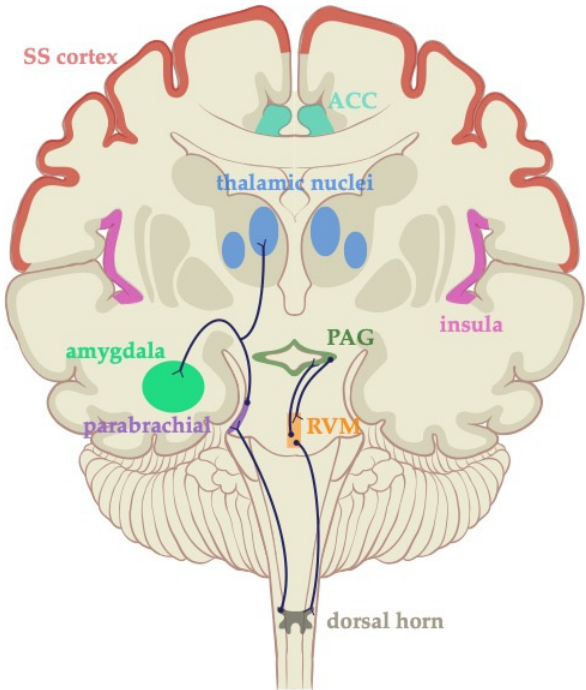
Figure 2. Descending pain modulatory pathway. The pathway originates in the cerebrum and descends to the periaqueductal gray (PAG) matter, rostral ventromedial medulla, and projects to the dorsal horn of the spinal cord. Bidirectional nociceptive pathways through the medullary nuclei are shown. The efferent pathway from the dorsal horn goes through the parabrachial nucleus, amygdala, and thalamic nuclei.